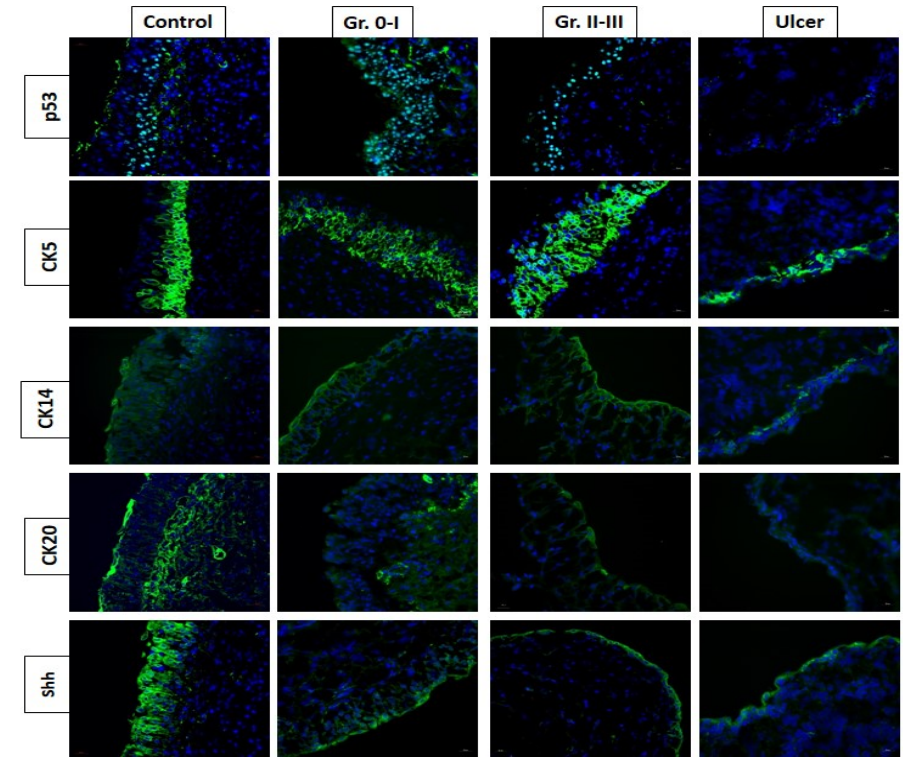
Figure 1. The expression of bladder urothelial proliferation and differentiation markers in different interstitial cystitis (IC)/bladder pain syndrome subtypes. The expression of sonic hedgehog (Shh) and cytokeratin (CK) 20 proteins are decreased in ulcer type IC and non-ulcer IC with high-grade glomerulations (Gr).